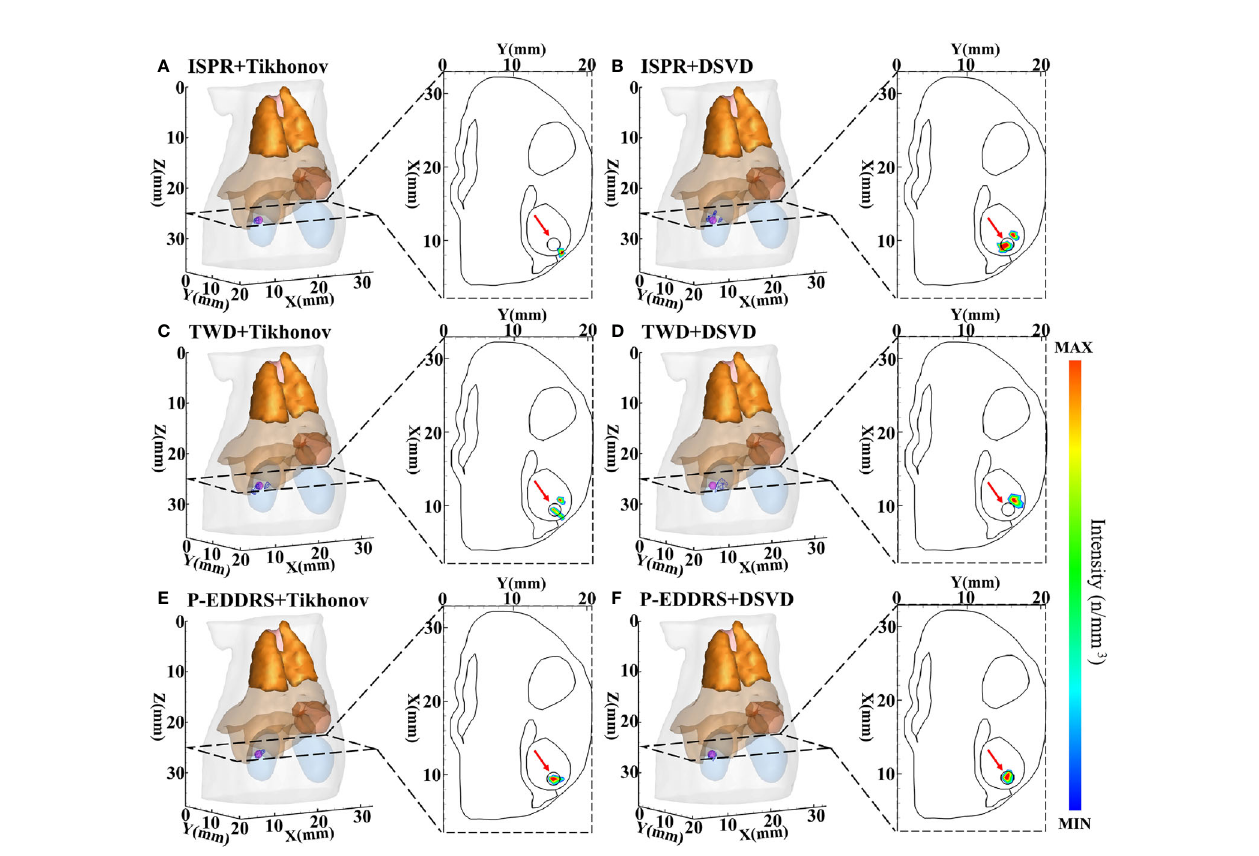
FIGURE 5 | Results of P-EDDRS framework ef fi ciency veri fi cation in CLT. All results include 3D views and corresponding cross-section views at the plane of Z = 25 mm. (A, B) The initial reconstruction source distribution of Tikhonov and DSVD algorithms in ISPR method, respectively. (C, D) The reconstruction source distribution of Tikhonov and DSVD algorithms in TWD strategy, respectively. (E, F) The reconstruction source distribution of Tikhonov and DSVD algorithms in our framework, respectively. P-EDDRS, probabilistic energy distribution density region scaling; CLT, Cerenkov luminescence tomography; DSVD, damped singular value decomposition; ISPR, iterative shrinking permissible region; TWD, three-way decision.